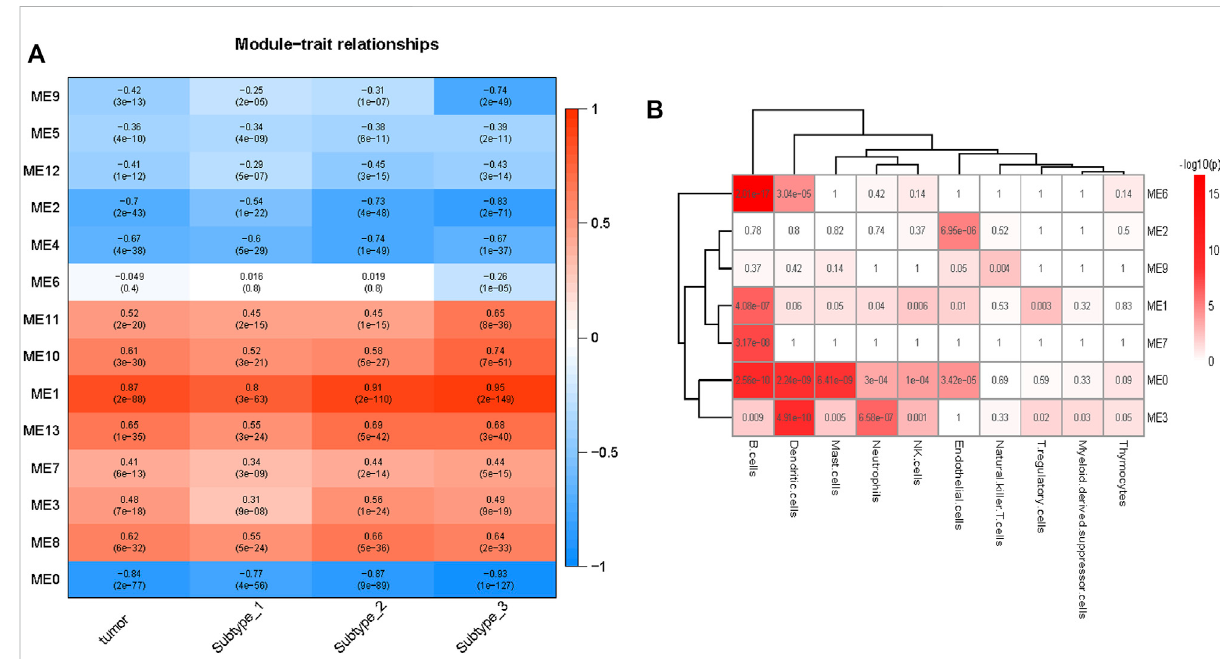
FIGURE 4 Overview of the modulesconstructed by WGCNA. (A) Correlationsof modules to tumor. Modules 1, 3, 7, 8, 10,11, and 13 are positive correlated with tumor and modules 0, 2, 4, 5, 9, and 12 are negative correlated with tumor. Module 6 was negatively correlated with Subtype 3 only. (B) Enrichment of various cells in different modules (module0, 1, 2, 3, 6, 7, and 9), the p values (Fisher ’ s exact test) are shown. B cells were enriched in modules 1, 3, and 6, the endothelial cells were enriched in modules 2 and